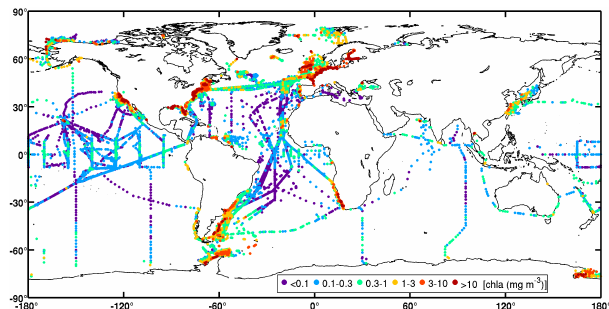
Figure 8. Global distribution of chlorophyll a concentration per in- tervals of the observed value. All chlorophyll data were considered, but for a given station HPLC data were selected if available.